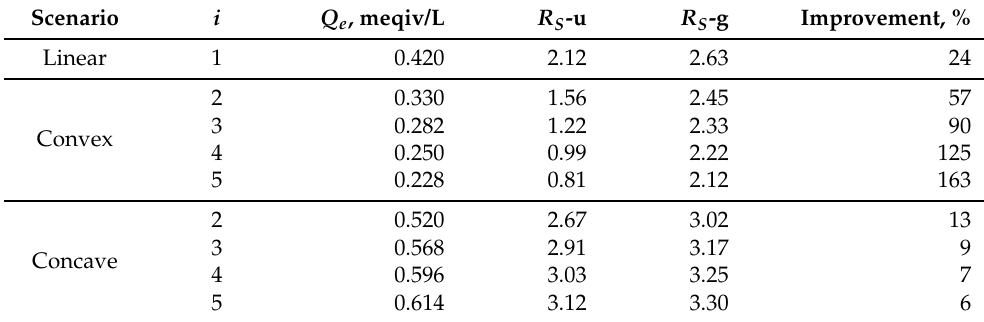
Table 3. Improvement in resolution for different ion-exchange capacity-profile